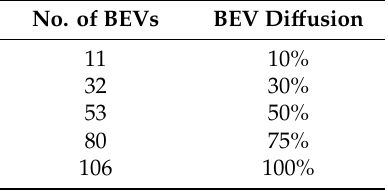
Table 2. Number of BEVs in the modeled multi-apartment building for BEV diffusion.